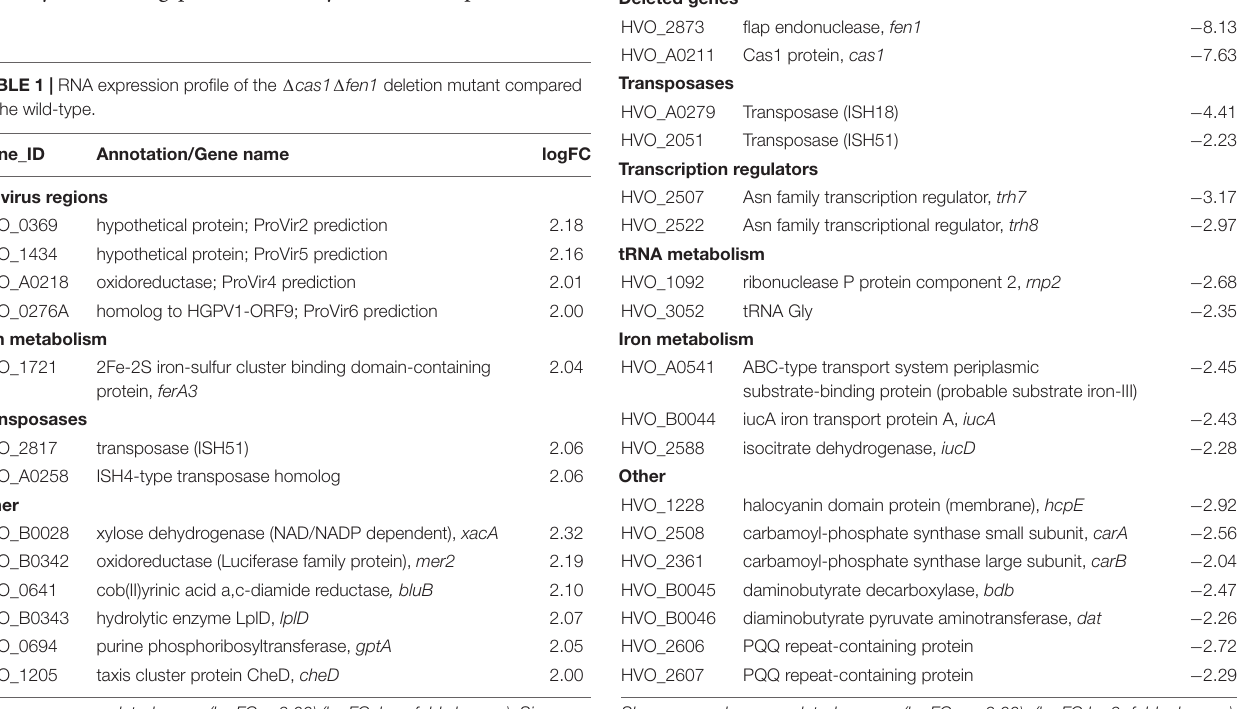
( Table 3 ), including several helicases and the DNA mismatch